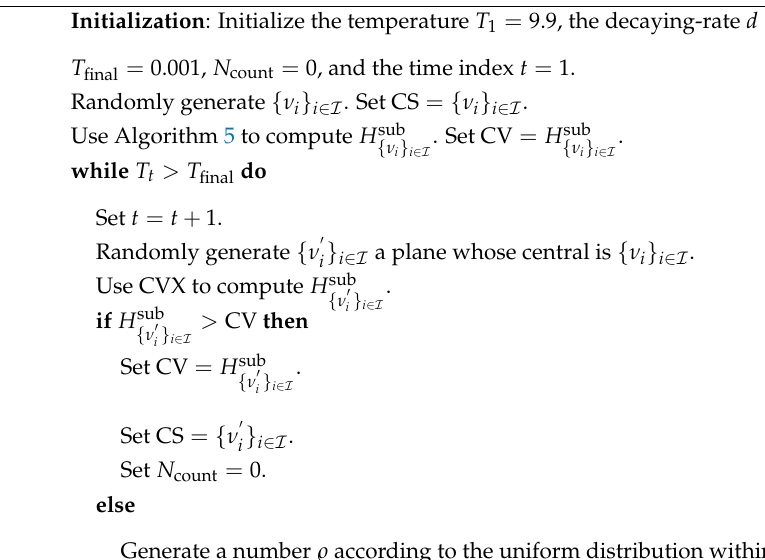
Algorithm 6: To solve Top-problem